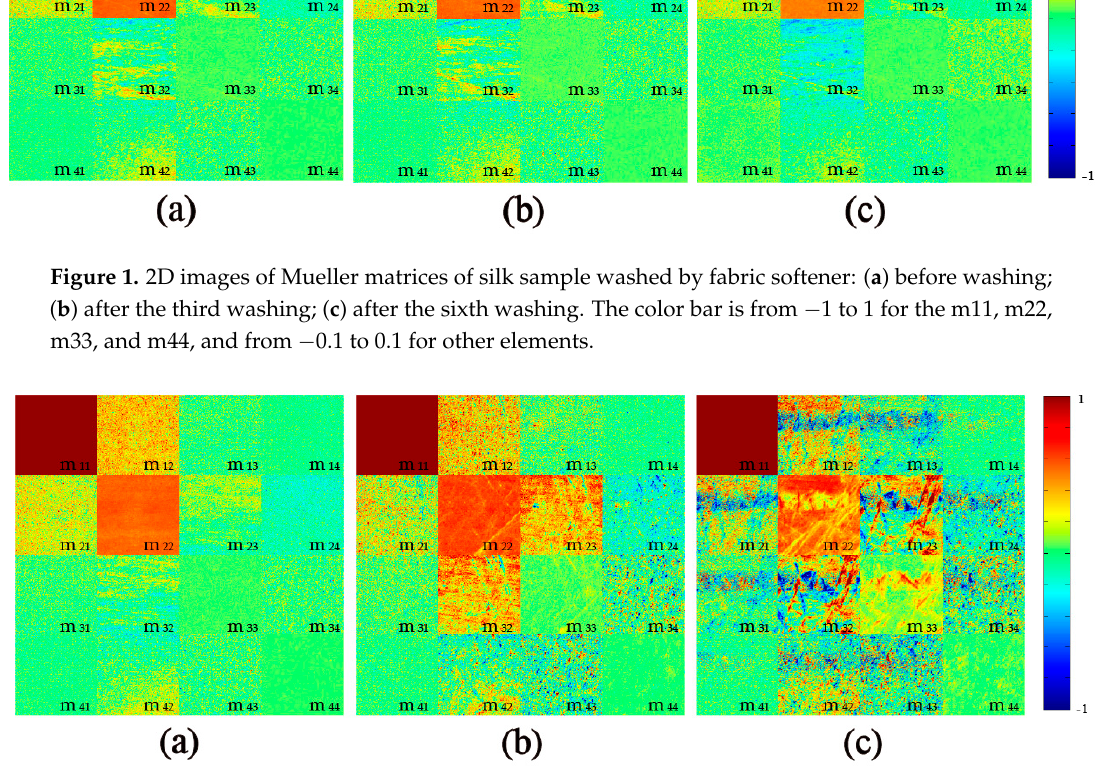
Figure 2. 2D images of Mueller matrices of silk sample washed by color stain net: ( a ) before washing; ( b ) after the third washing; ( c ) after the sixth washing. The color bar is from − 1 to 1 for the m11, m22, m33, and m44, and from − 0.1 to 0.1 for other elements.